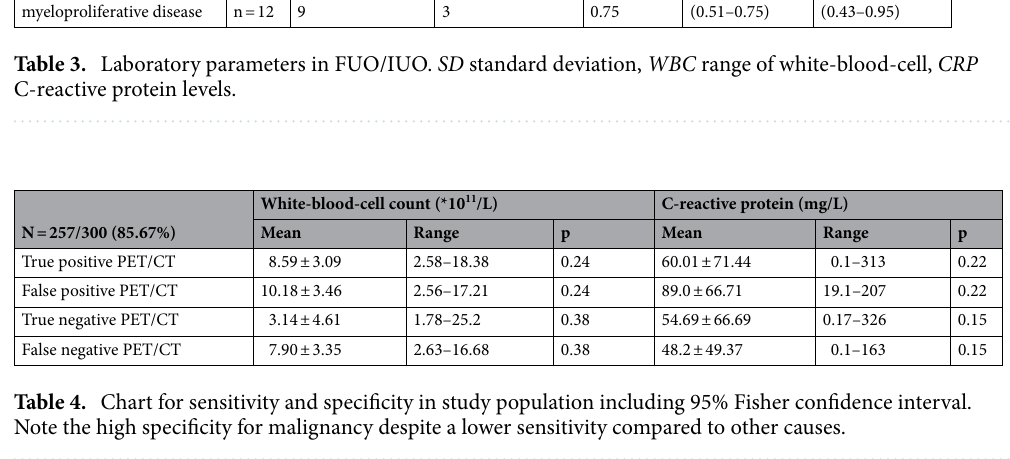
Table 4. Chart for sensitivity and specificity in study population including 95% Fisher confidence interval. Note the high specificity for malignancy despite a lower sensitivity compared to other causes.